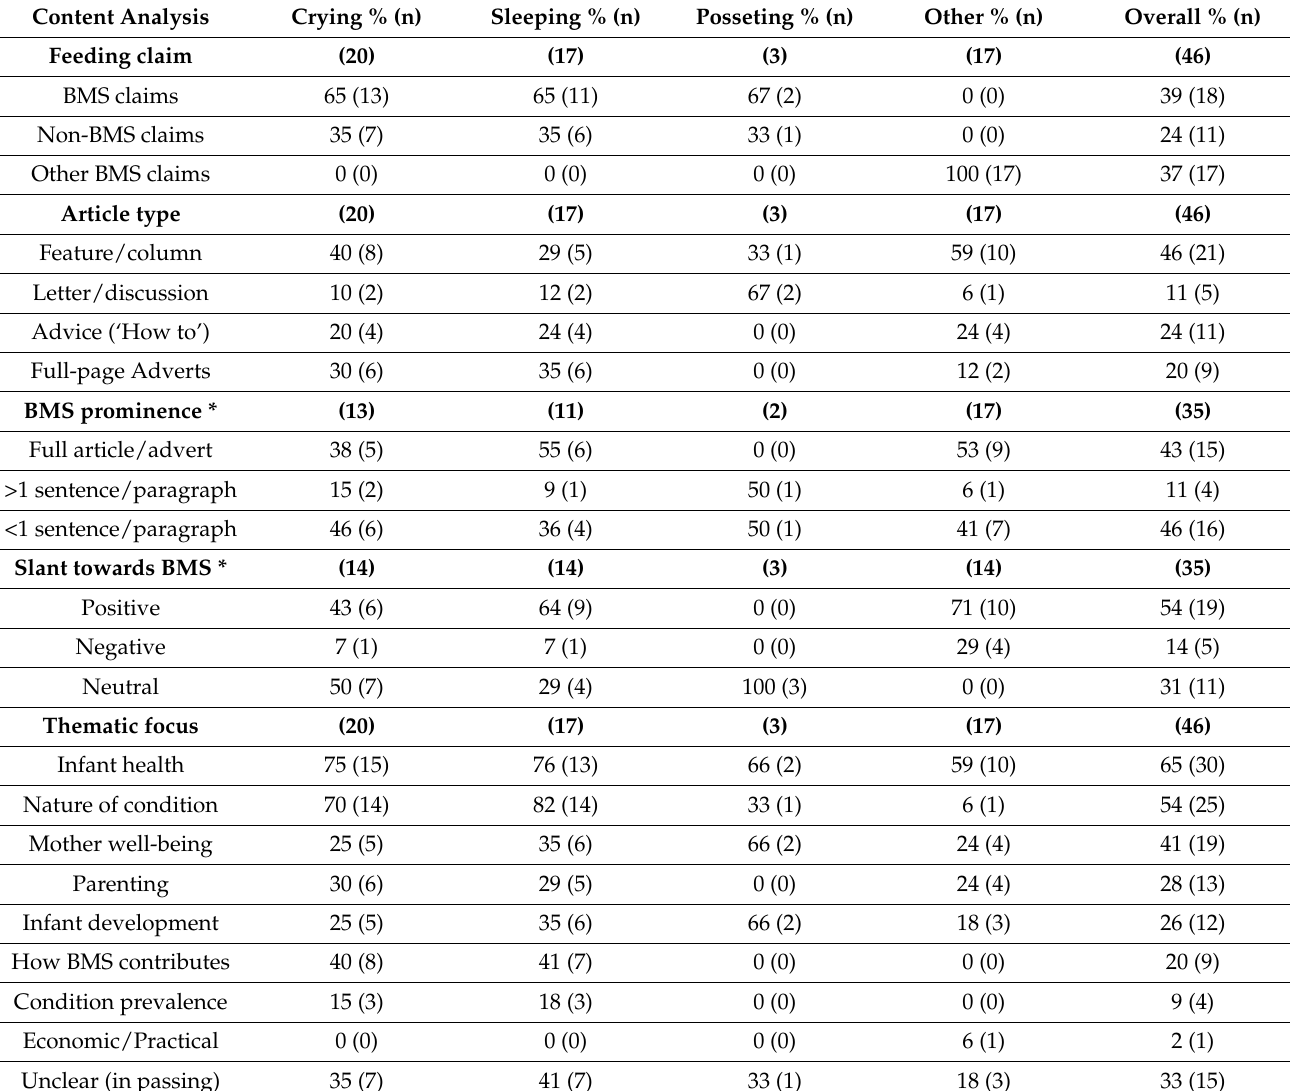
Table 1. Content analysis of text in two parenting magazines, by claim type and